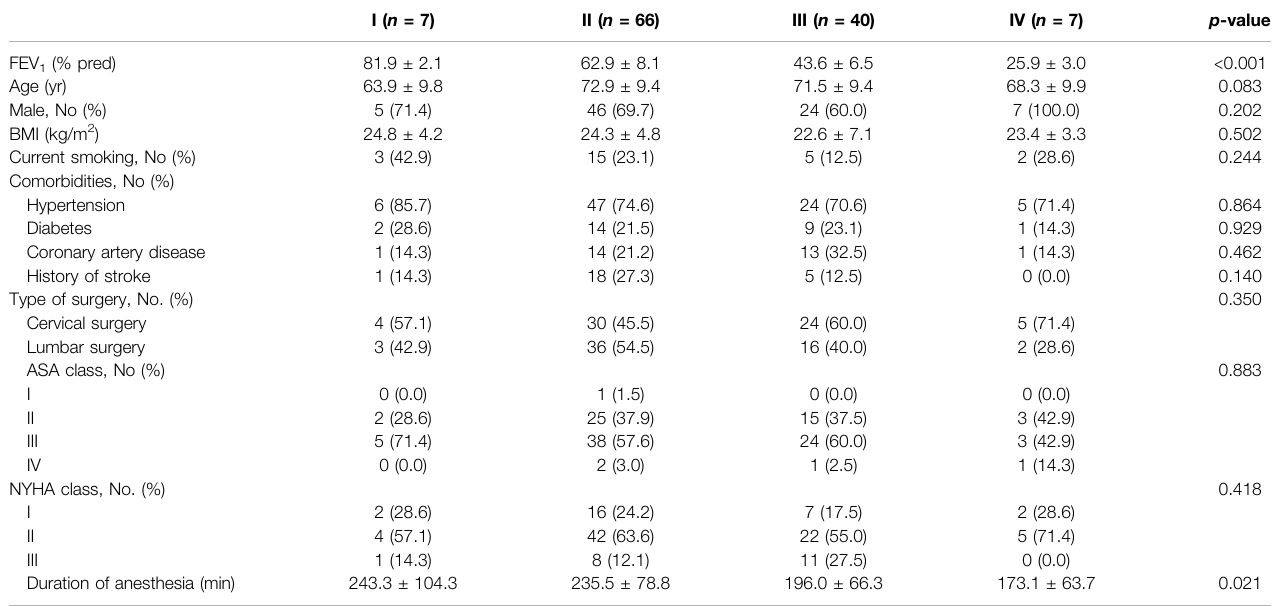
TABLE 1 | Demographics and intraoperative